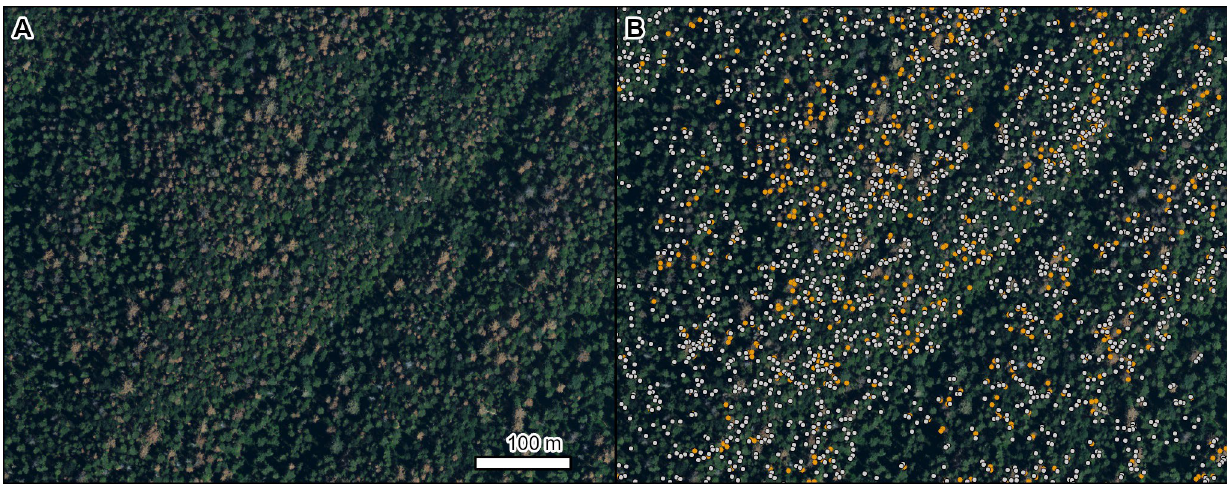
Fig 7. Mortality of ponderosa pine ( Pinus ponderosa ) caused by western pine beetle ( Dendroctonus brevicomis ). Left panel is NAIP imagery from 2016 (A). Right panel (B) shows the damaged tree crowns as points on top of the 2016 NAIP imagery (orange = red crowns, light gray = gray crowns). Location: Sequoia National Forest, California. Insect and Disease Survey database DAMAGE_AREA_ID: 20165031067. NAIP imagery (public domain) provided by